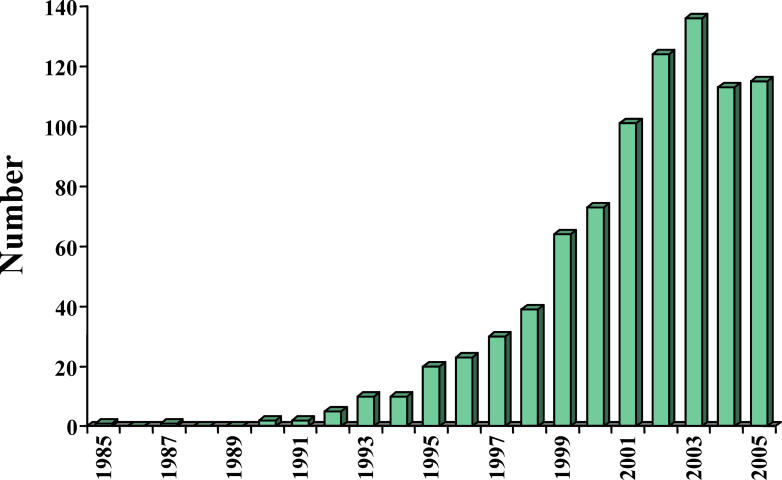
Articles Elicited by Medline Using the Mesh Term “Mood Stabilizer”